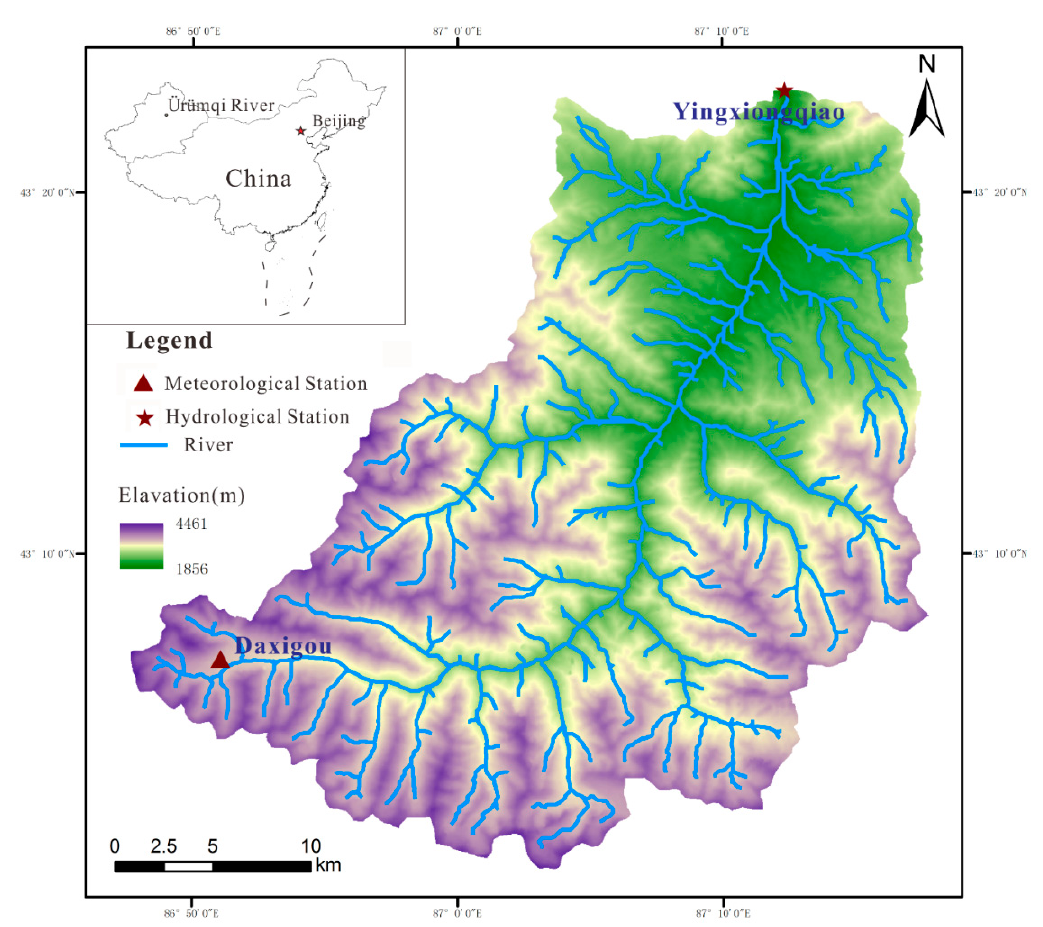
Figure 1. The DEM map and hydrometeorological observation sites in the upstream of Urumqi River basin.